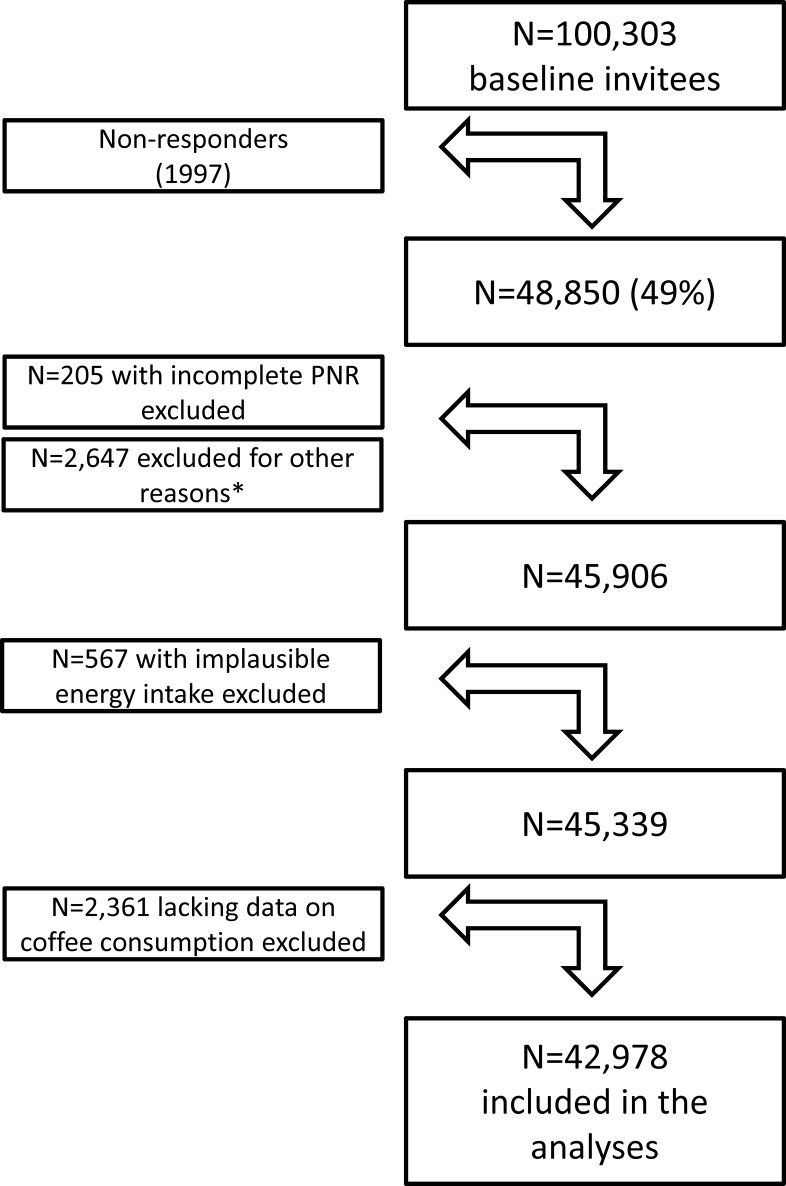
A flow chart describing the Cohort of Swedish Men (COSM).*Reasons for exclusions were: erroneous personal identification number, questionnaires not dated, erroneous dates of moving out of the study area or death, and a cancer diagnosis (except for non-melanoma skin cancer and only before the baseline questionnaire). Implausible energy intake was defined as ±3SD from the mean value of the log-transformed reported energy intake. Finally, individuals with lacking data on coffee consumption were excluded in the analyses. PNR: personal identification number.